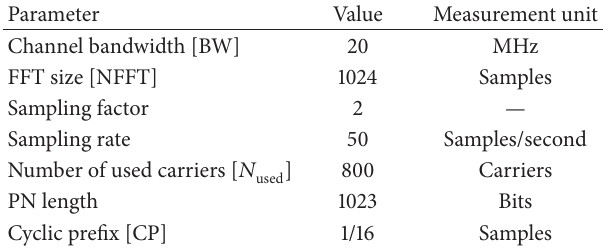
Table 1: Parameters of the OFDM test